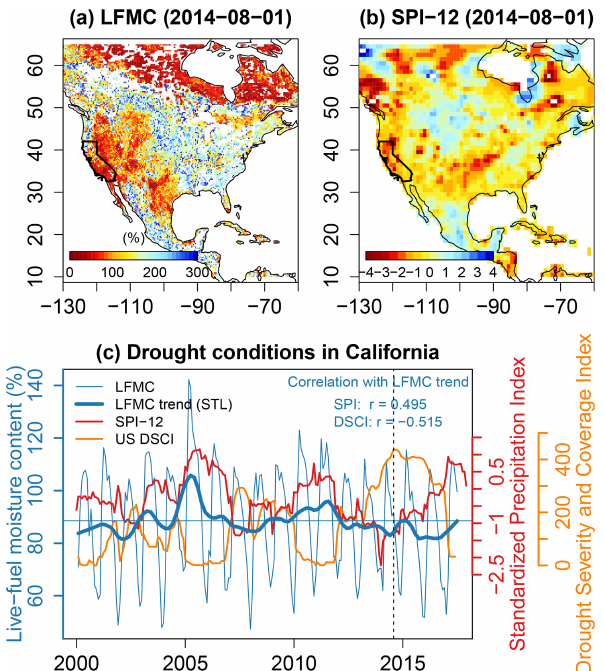
Figure 10. Comparison of LFMC as estimated from model B with drought conditions in North America and California. (a) Map of mean monthly LFMC for August 2014, a month with severe drought in the western United States. The state of California is highlighted in the map. (b) Map of the Standardized Precipitation Index for 12-monthly accumulation periods (SPI-12) for August 2014. SPI- 12 data are taken from Global Drought Observatory – JRC Euro- pean Commission (2022). (c) Comparison of LFMC, SPI-12, and the US Drought Severity and Coverage Index (DSCI) for Califor- nia. A severe drought started in California (and in the western US) in 2013 and lasted until end 2016, as shown by negative SPI-12 val- ues, very high DSCI values, and low LFMC. The dashed vertical line corresponds to August 2014, which is shown as map in pan- els (a) and (b)